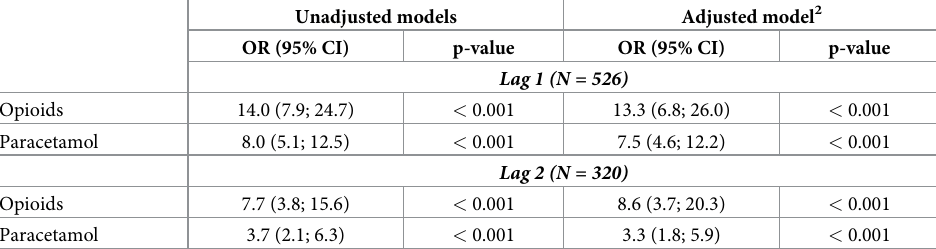
Table 3. Analgesic drug use at one time adjusted for use one or two time points earlier 1 . Results of generalized lin- ear mixed